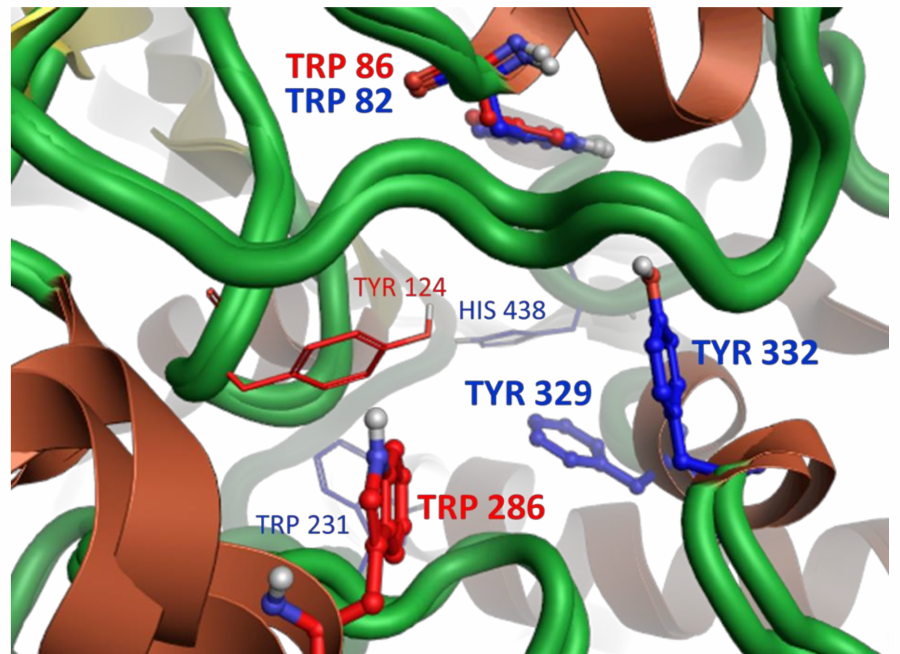
Figure 3. The cartoon model of the superimposed AChE’s and BuChE’s pockets with the ball-and- stick representations of the key ligand-binding aromatic residues in the pockets of AChE (red) and BuChE (blue). Note that both enzymes share the position of one ligand-binding region, which correspond to the TRP 86 and TRP 82 residues in AChE and BuChE,